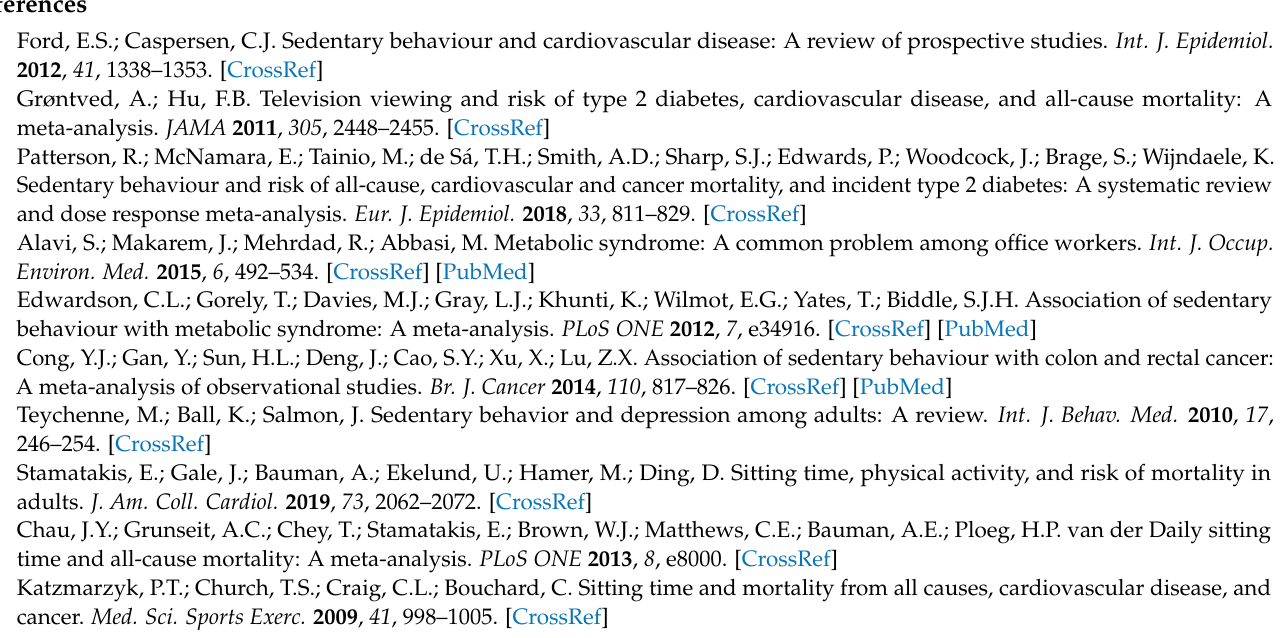
Table S2a,b: Charity 12 week “sit less at work” intervention summary and detailed action plan. Table S3a,b: Local authority 12 week “sit less at work” intervention summary and detailed action plan. Table S4: Participation numbers during the intervention